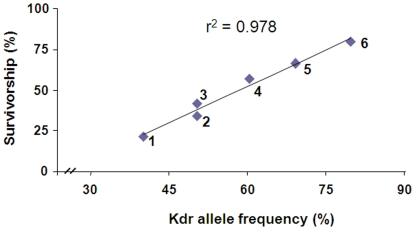
Relationship between mosquito survivorship in WHO insecticide susceptibility bioassay and frequency of kdr alleles (L1014F and L1014S) combined of Culex pipiens pallens.Numbers in the figure corresponds to the following sample localities: 1, Nanjing; 2, Wuxi; 3, Weishan; 4, Huaibei; 5, Qingdao; and 6, Tangkou.